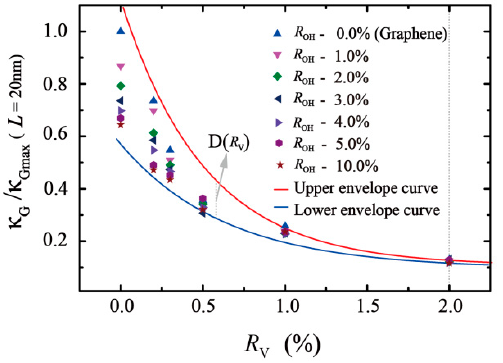
Figure 6. The relative thermal conductivity of GO with varying degrees of oxidation and vacancy defect ratio in the same sample size of 20 nm. Six different symbols indicate the different degree of oxidation with varied vacancy defect ratios, the red and blue line denote the fitting curves.